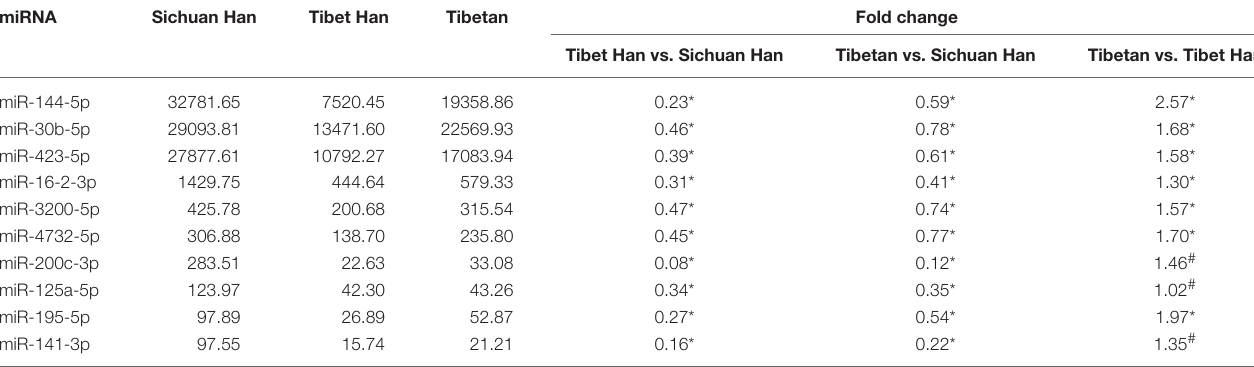
TABLE 1 | Markedly altered miRNAs in pooled RBC samples from the Tibet Han group compared with the Sichuan group as determined by miRNA sequencing. miRNA